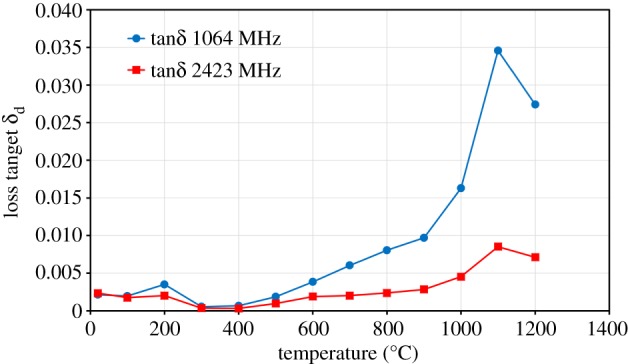
Loss tangent (δd) of ZnFe2O4 as a function of temperature at frequencies of 1064 MHz and 2423 MHz.